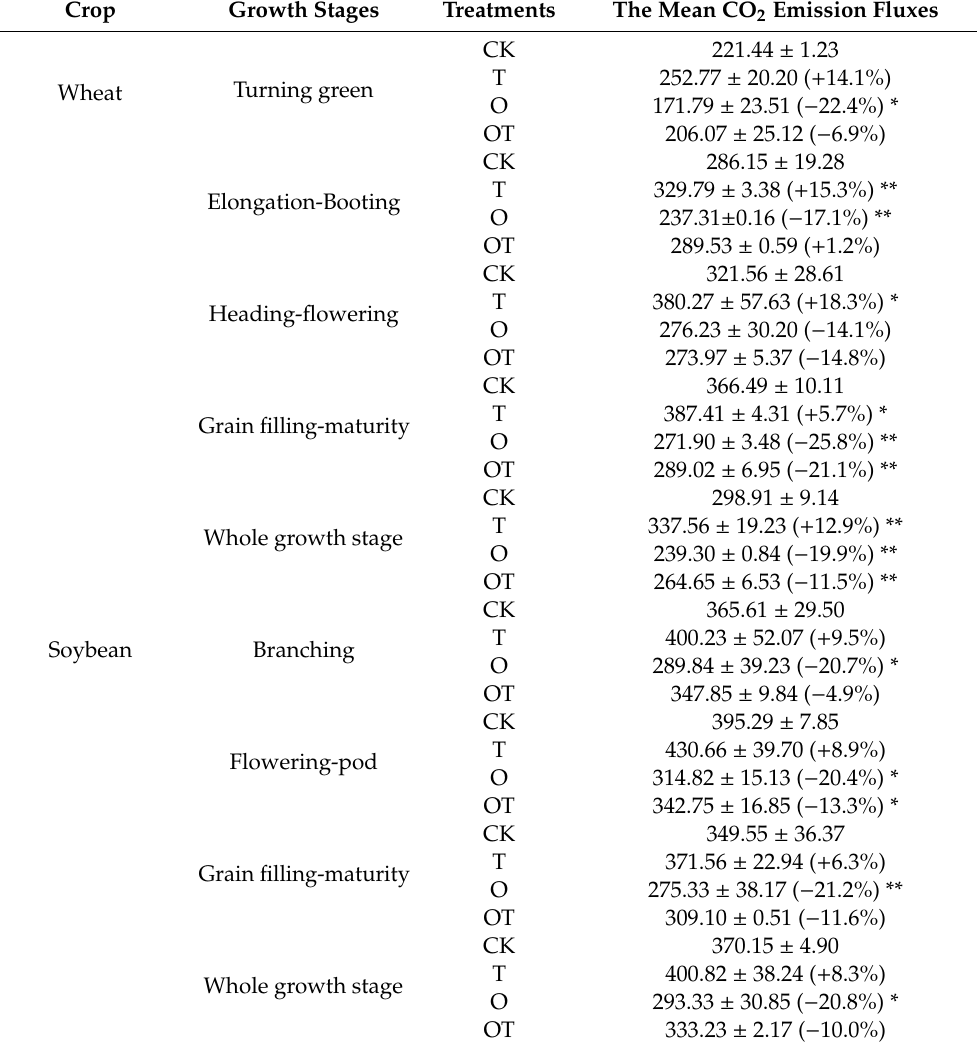
Table 3. E ff ect of warming and elevated O 3 concentration on mean CO 2 emission fluxes from soil (mg · m − 2 · h − 1